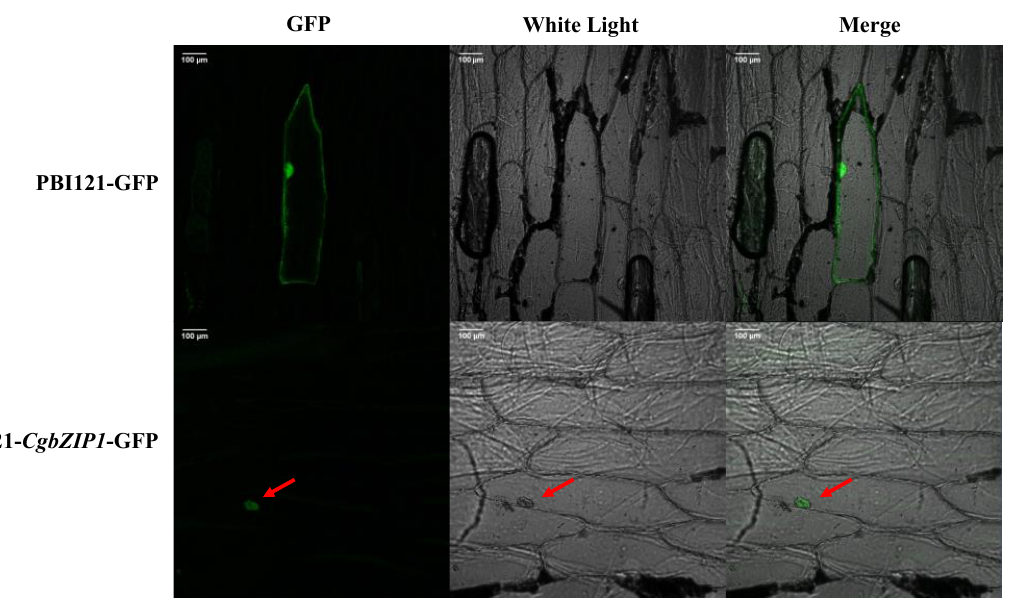
Figure 4. Subcellular localization of CgbZIP1 in onion epidermal cells. Genes encoding GFP and CgbZIP1 – GFP fusion proteins were driven by the CaMV35S promoter. Nuclear localized signals of the CgbZIP1 – GFP fusion protein were indicated by arrows. Bars = 100 µm.